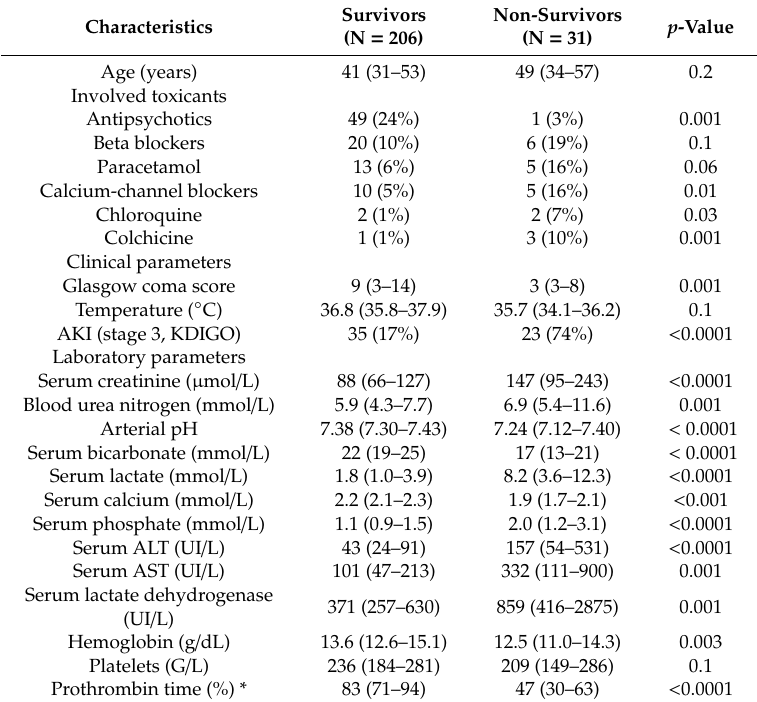
Table 8. Clinical and laboratory parameters in the poisoned patients who developed rhabdomyolysis according to survival in the intensive care unit.